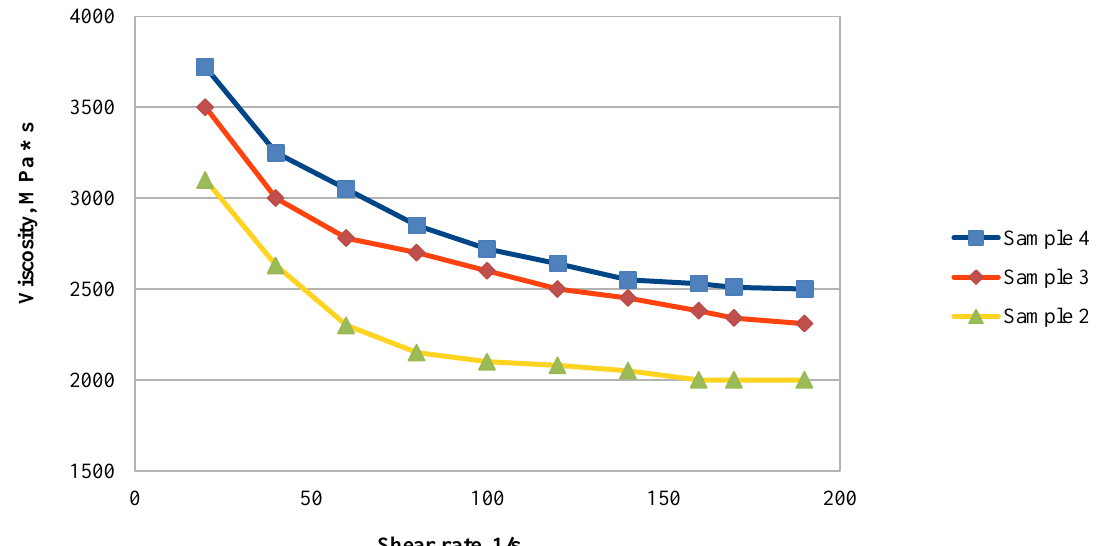
Fig. 2. Dependence of structural viscosity of Carbopol® Ultrez 10 based gel samples on shear rate